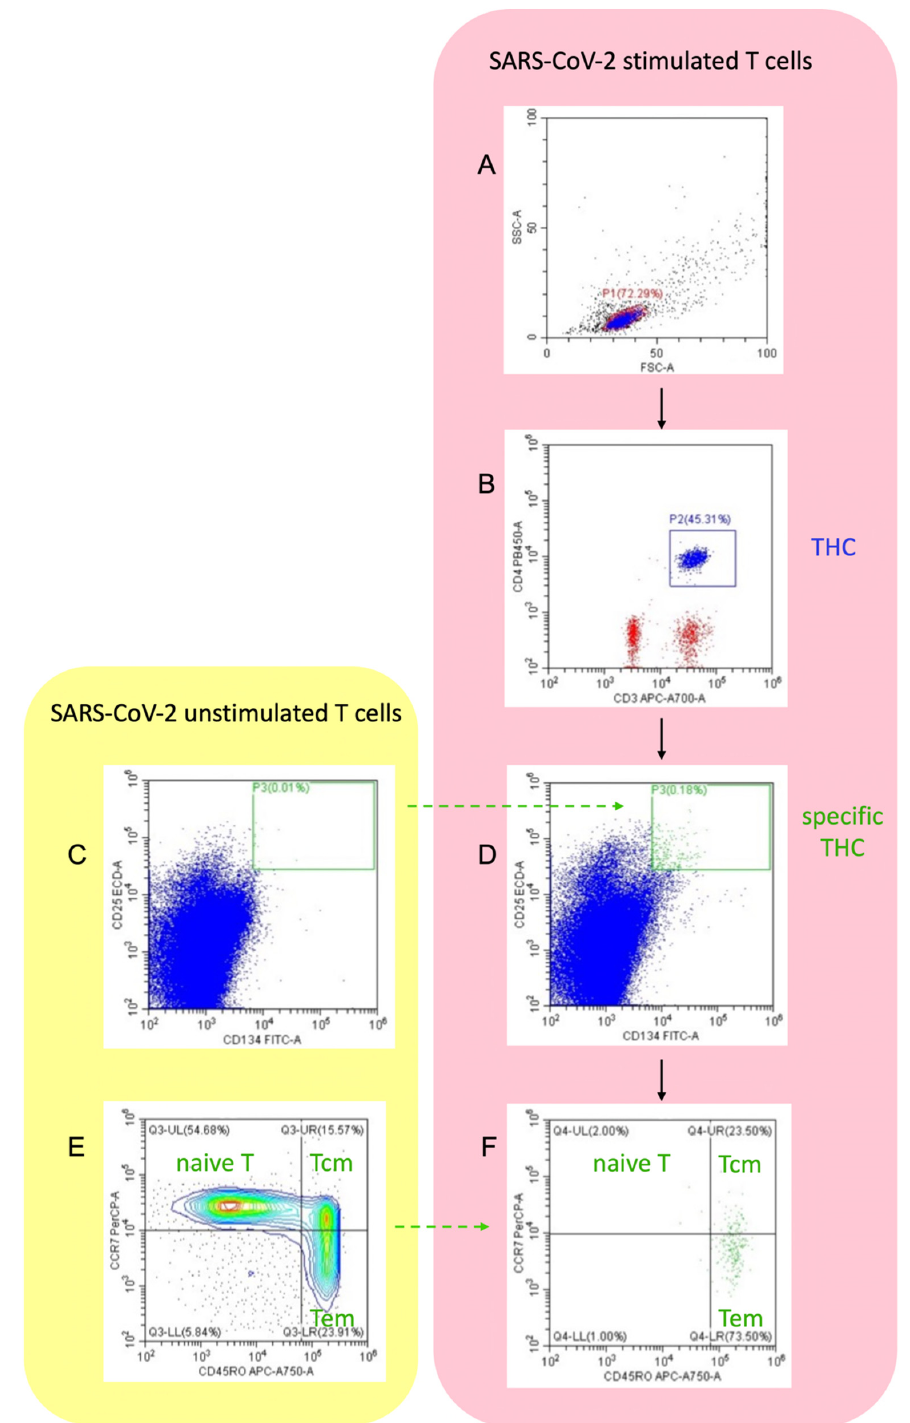
Figure 1. Flow cytometric gating strategy of AIM assay to identify specific T-helper cells (THC), and central memory T-cell (Tcm) and effector memory T-cell (Tem) subsets from a participant included in the study: ( A ) lymphocytes (Gate P1) were gated using forward and side scatter; ( B ) gated on P1: THC (Gate P2) were defined by co-expression of CD3 and CD4; ( D ) gated on P2: specific THC (Gate P3) were analyzed as CD25 high/CD134 high double-positive cell population after stimulation with SARS-CoV-2; ( C ) borders of Gate P3 were defined by means of unstimulated THC population; ( F ) gated on P3: specific THC were further divided into Tcm and Tem; ( E ) borders between Tcm, Tem and naïve T-cells were defined by unstimulated THC.